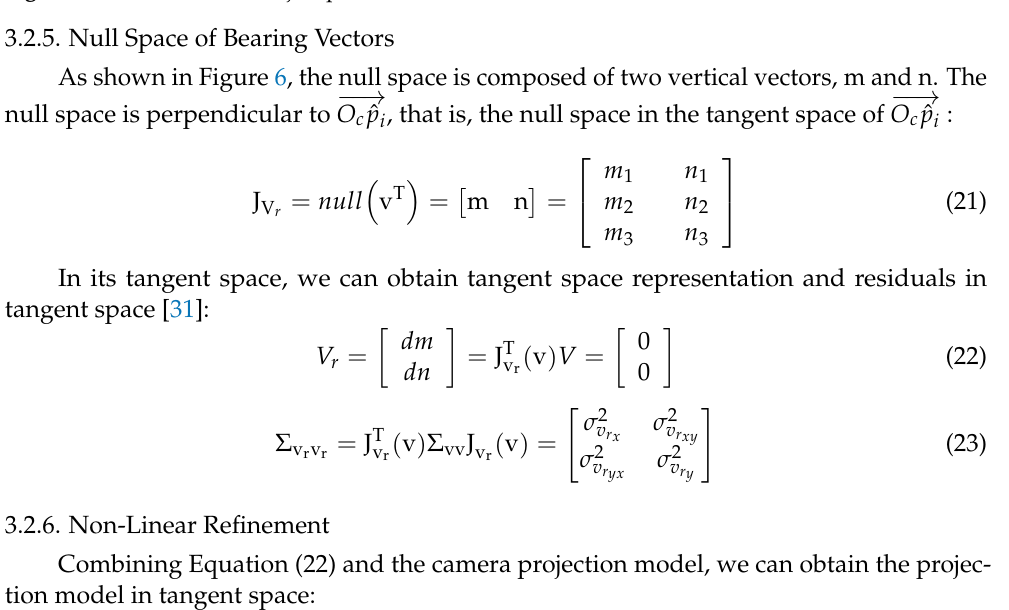
Figure 6. Observations of object points from a